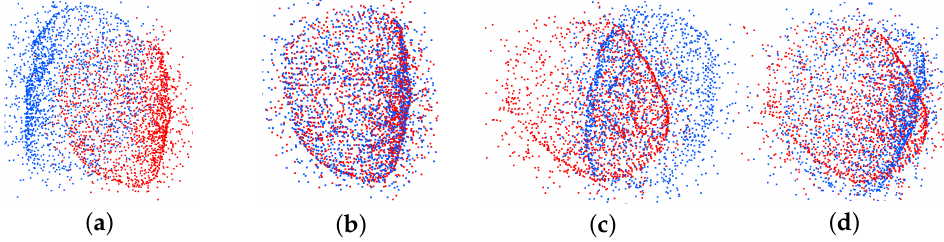
Figure 6. ( a ) Source cloud P (blue), target cloud Q (red) in the initial position; ( b ) result of alignment; ( c ) source cloud P (blue), target cloud Q (red) in the other initial position; ( d ) result of alignment. For the non-congruent point clouds, we used the threshold (cid:107) M true − M est (cid:107) F = 0.6 as a criterion for convergence to the true transformation for all tested